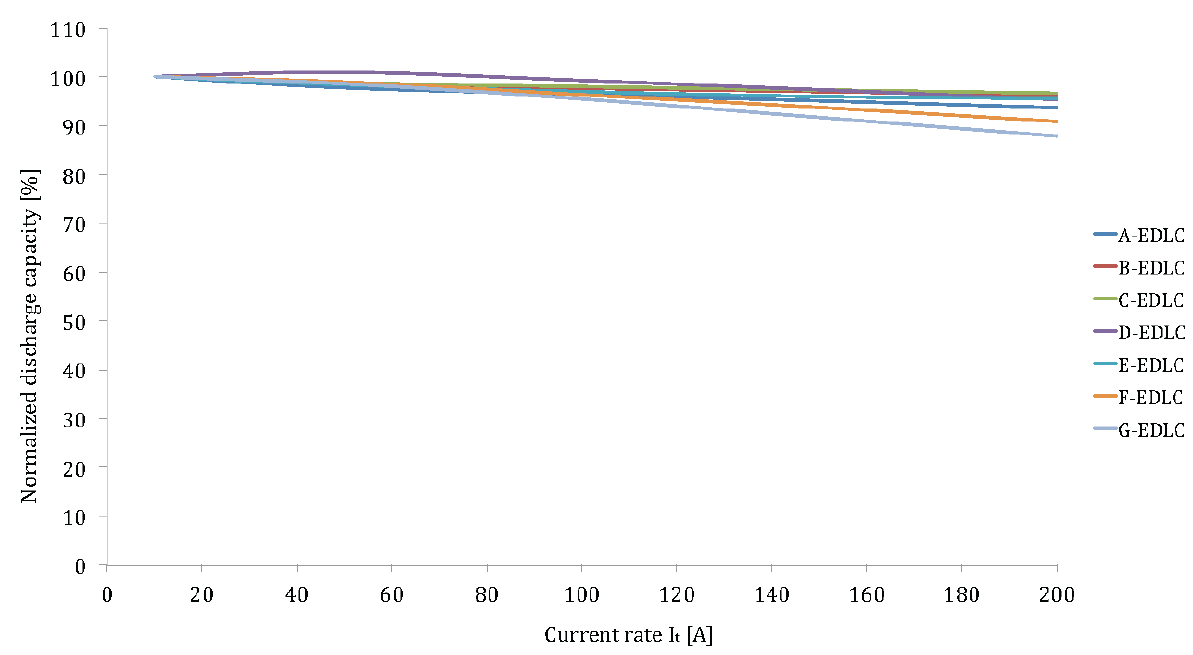
Figure 15. Discharge rate capabilities of the investigated